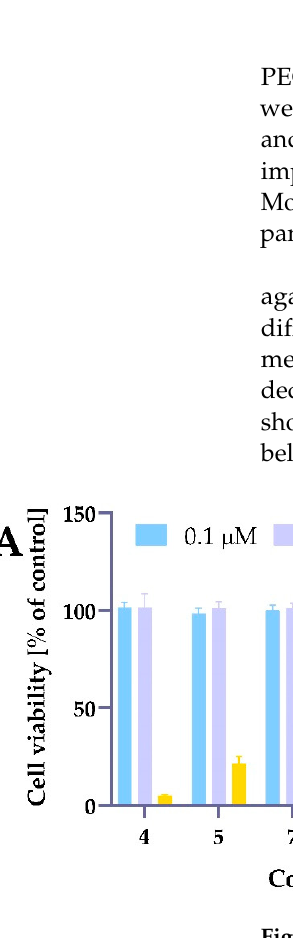
Figure 7. The preliminary data indicated the most promising structure for further research. Panel ( A ) presents the cytotoxic effects of compounds 4 , 5 , 7 , 8 , 10 , and 13 after treatment lasting 24 h, while panel ( B ) presents cell viability for 48 h. The 5637 cells were treated with compounds 4 , 5 , 7 , 8 , 10, and 13 at a concentration of 0.1 µ M, 1 µ M, and 10 µ M for 24 h and 48 h. Cell viability was measured by MTT assay.